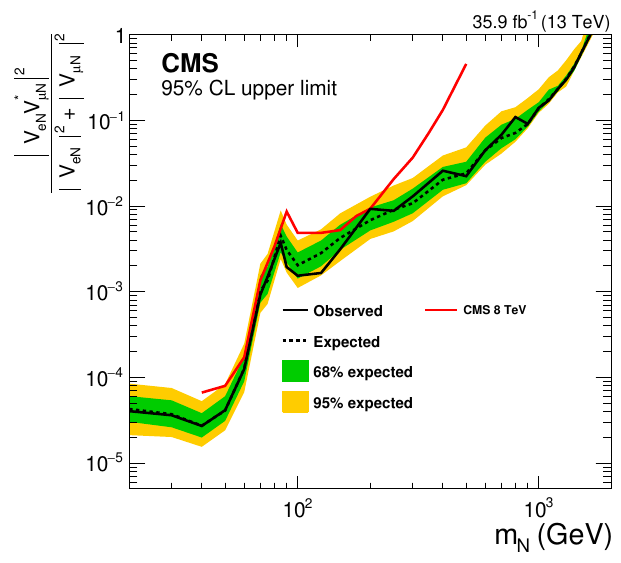
2 = ( 2 + 2 ) vs. m V eN V (cid:3) V eN V (cid:22) N N plane. The (cid:22) N j j j j j j